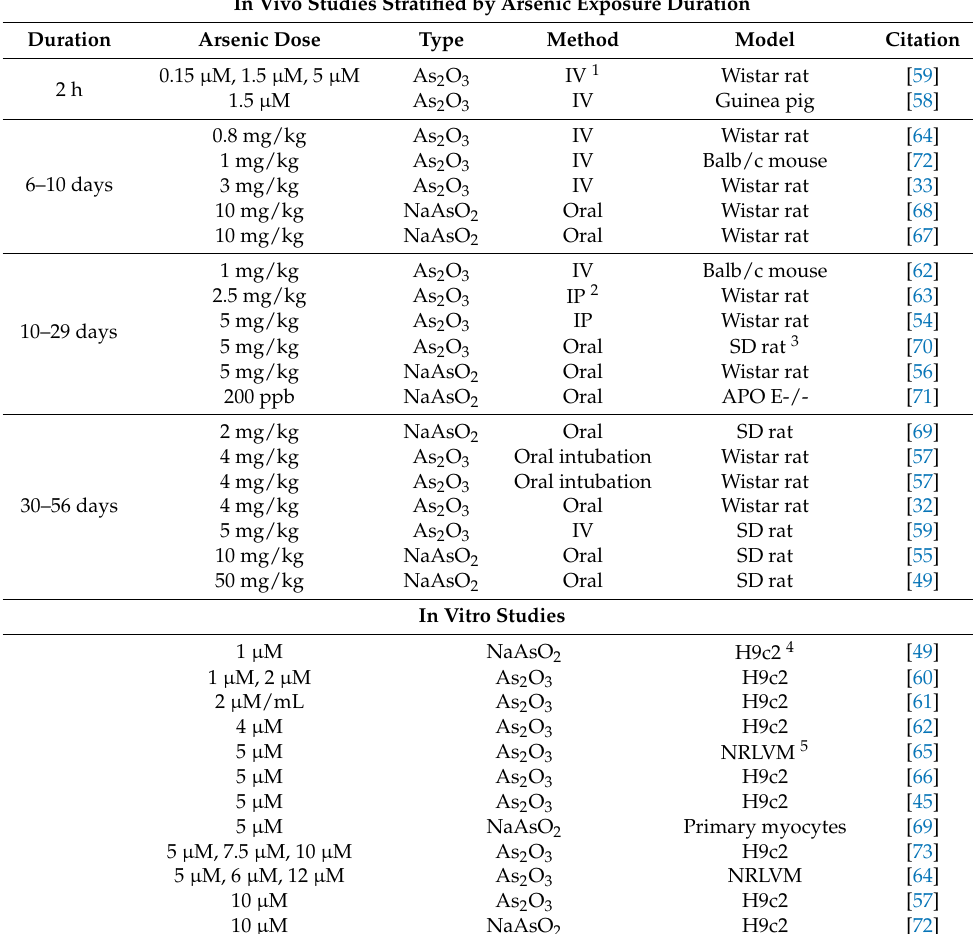
Table 1. In vivo and in vitro study design.